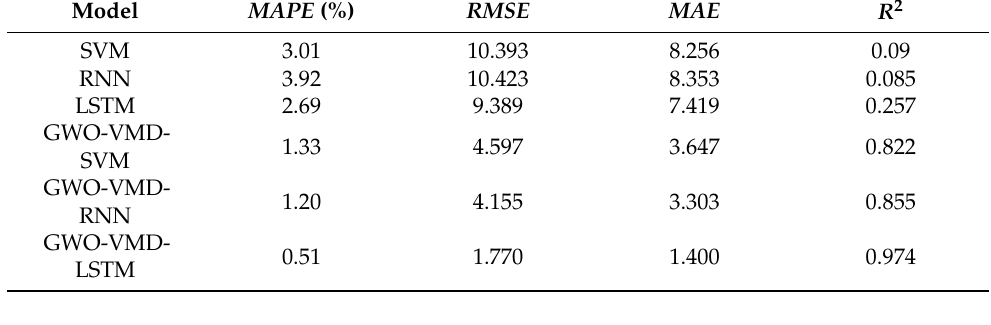
Table 3. Performance prediction for each model of selected dataset.